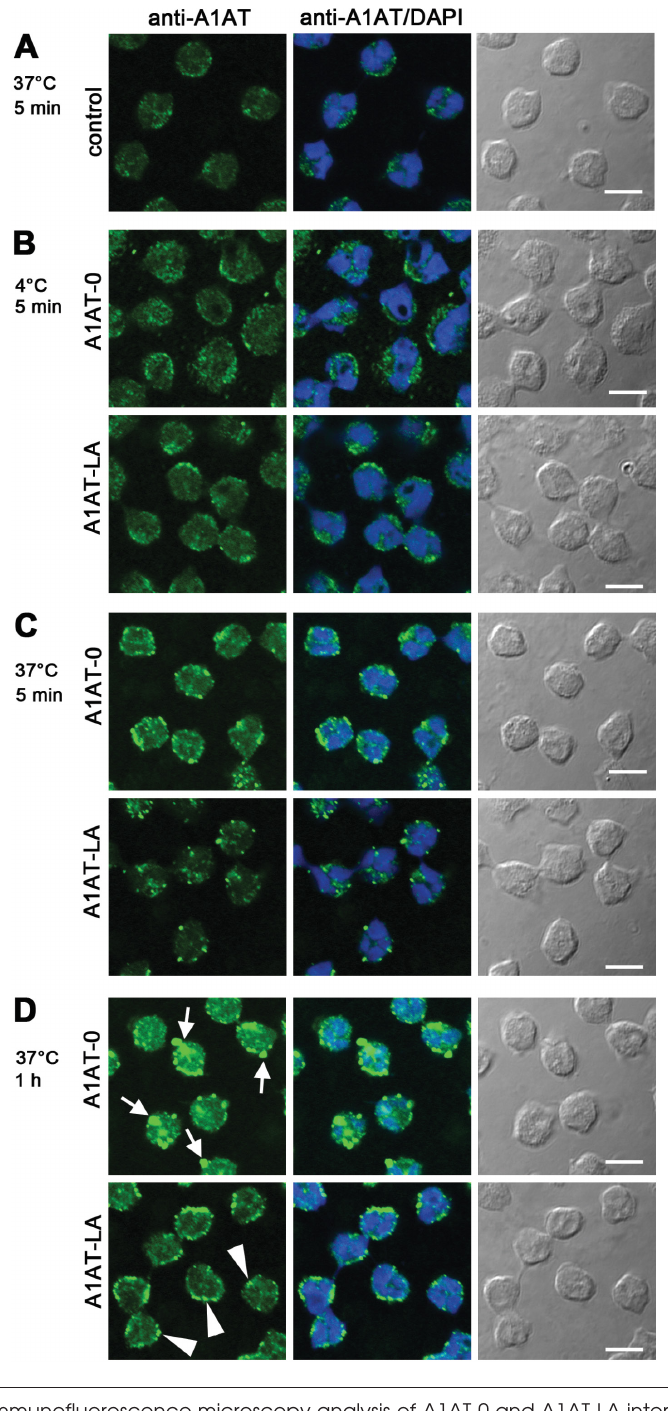
Figure 8. Immunofluorescence microscopy analysis of A1AT-0 and A1AT-LA interaction with neutrophils. Neutrophils were incubated alone as controls for 5 min at 37°C (A), or with either A1AT-0 or A1AT-LA for 5 min at 4°C (B), or for 5 min and 1 h at 37°C (C). Cells were stained with anti-A1AT antibody (green) and DAPI (blue). Arrows point to the larger A1AT-reactive granules formed upon A1AT-0 treatment as compared with those of A1AT-LA (arrowheads). Images were acquired using Olympus FluorView 1000 scanning confocal microscope equipped with a 60 × oil immersion objective. Scale bar: 10 μ